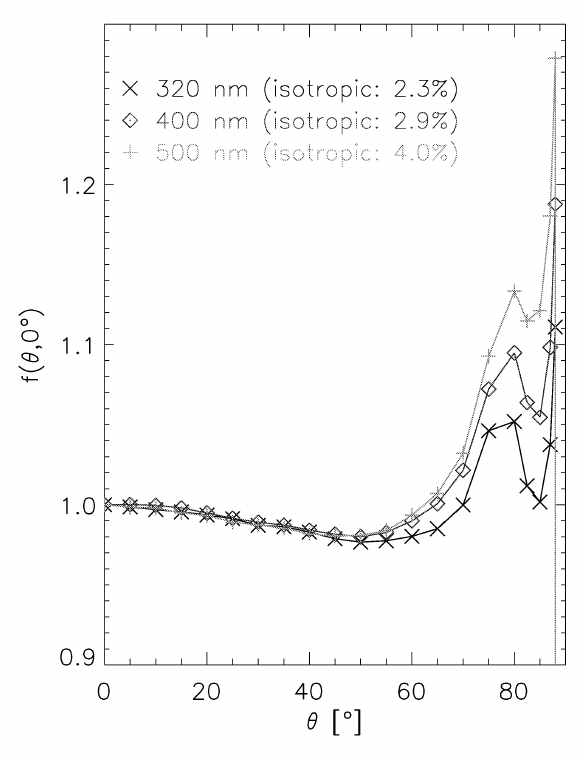
Fig. 1. The deviation from the ideal cosine response of the IMUK entrance optics for different wavelengths and one azimuth